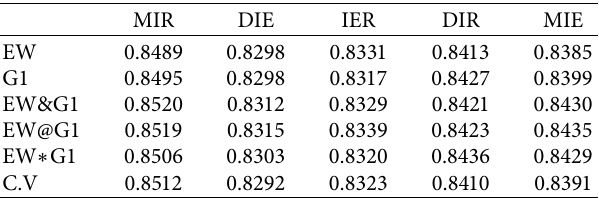
Table 5: Flower data